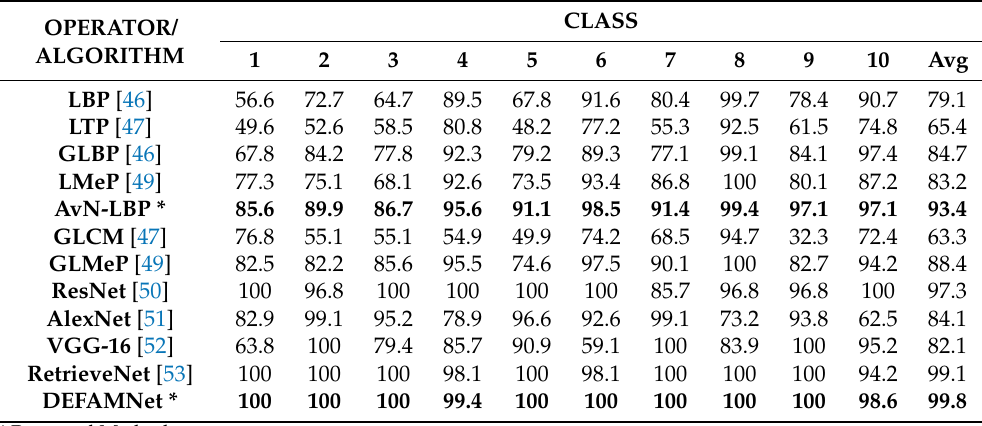
Table 2. Comparison of Percentage Retrieval Accuracy (ARP) on the I-ELCAP database.